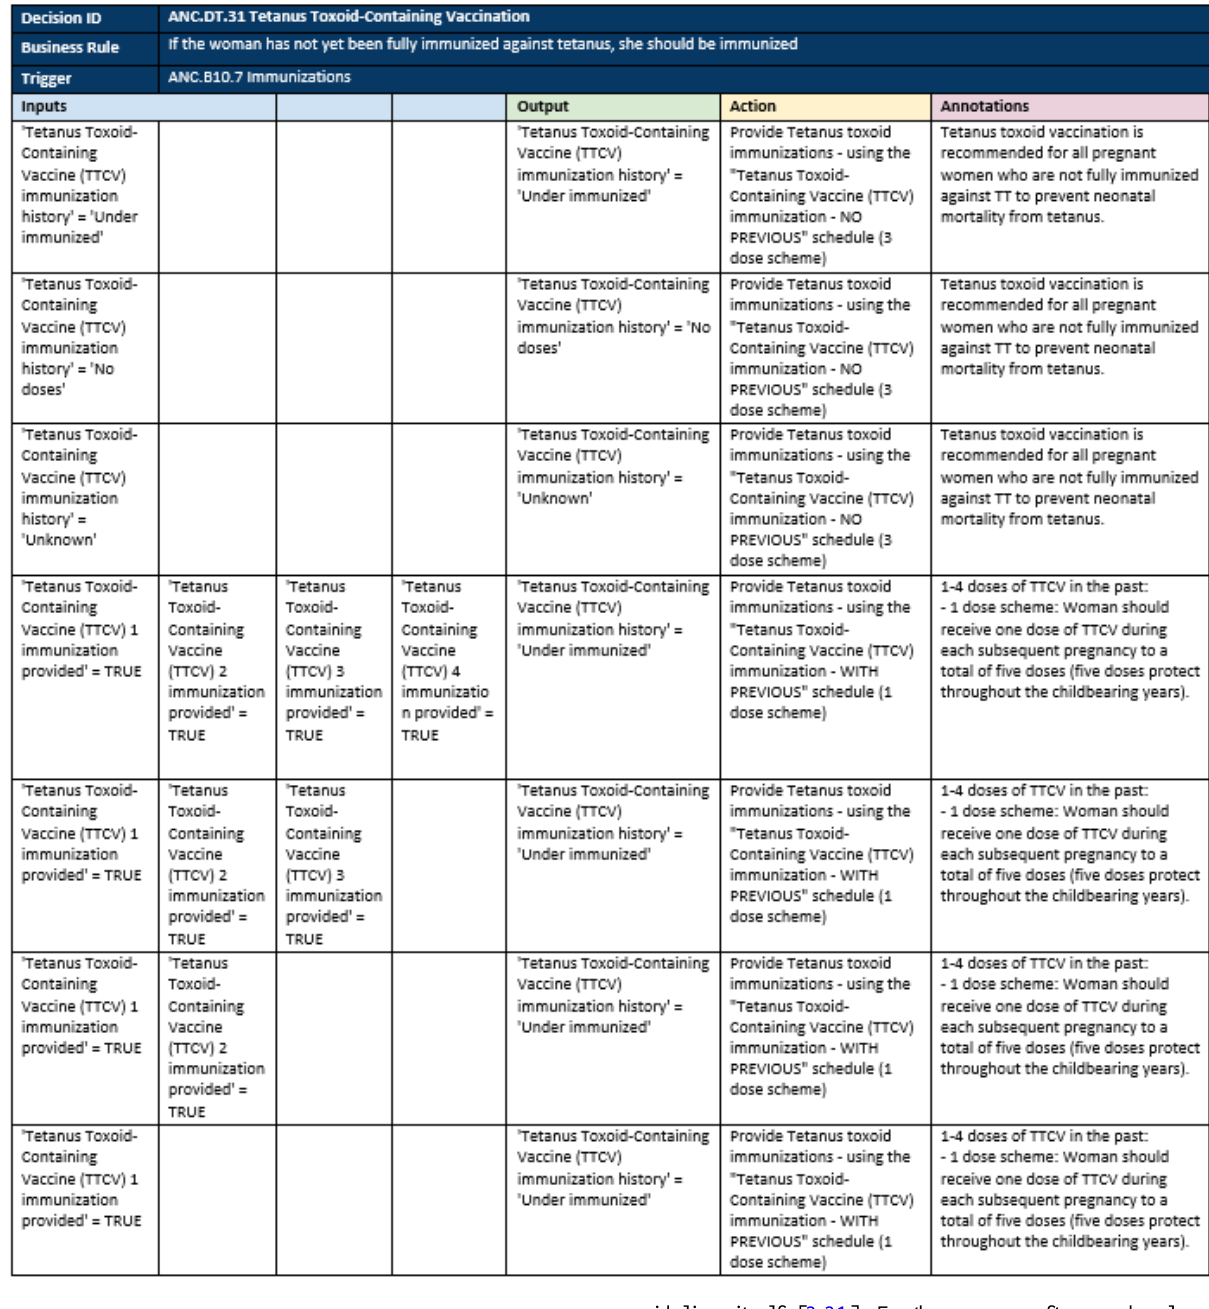
Figure 7. Example decision-support